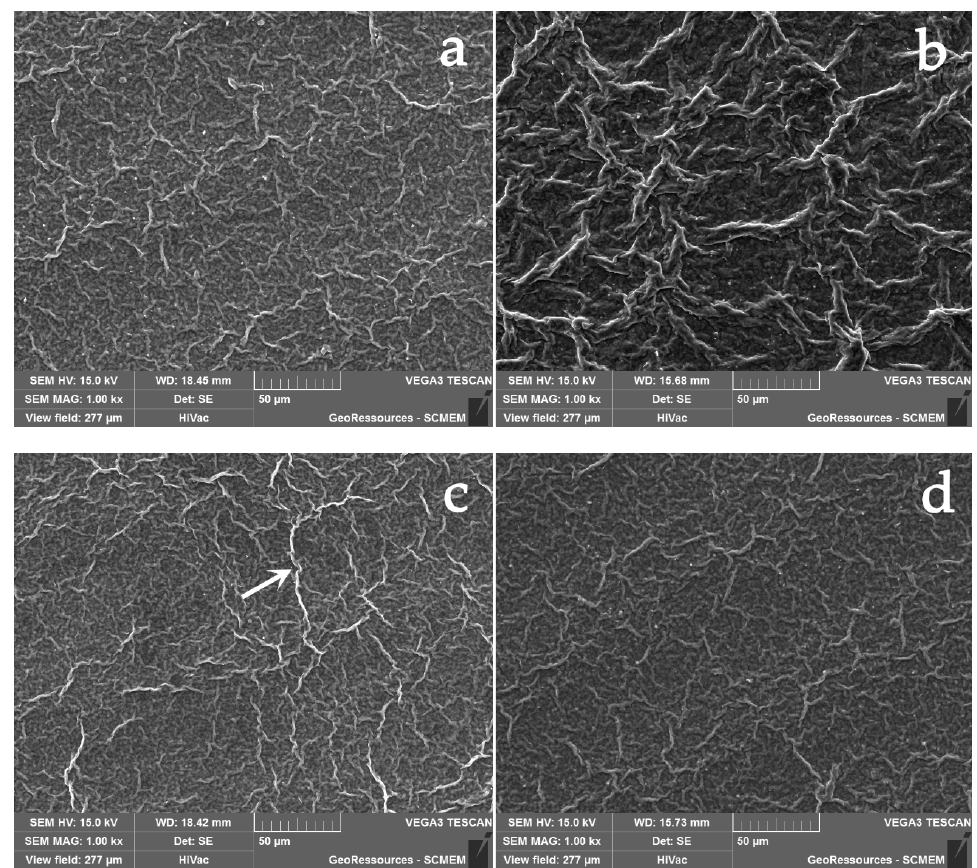
Figure 8. SEM images of bentonite suspension prepared at ( a ) pH 4 in 1 × 10 − 2 M KNO 3 , ( b ) pH 4 in 1 × 10 − 2 M NaCl, ( c ) pH 8 in 1 × 10 − 2 M KNO 3 , and ( d ) pH 10 in 1 × 10 − 2 M KNO 3 and deposited on Al stubs followed by drying and carbon